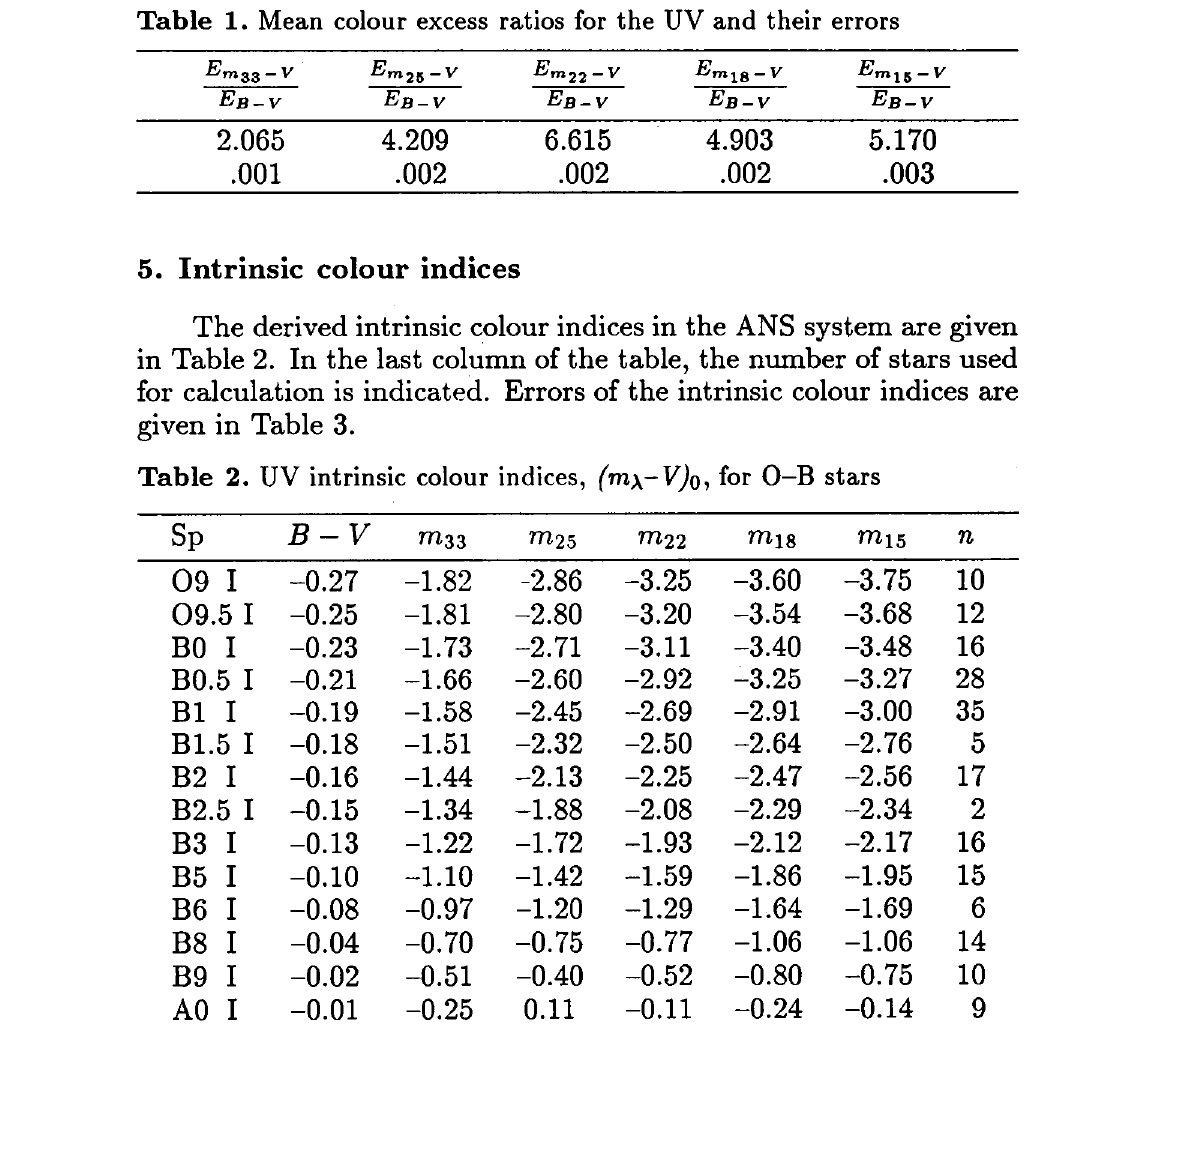
Table 1. Mean colour excess ratios for the UV and their errors